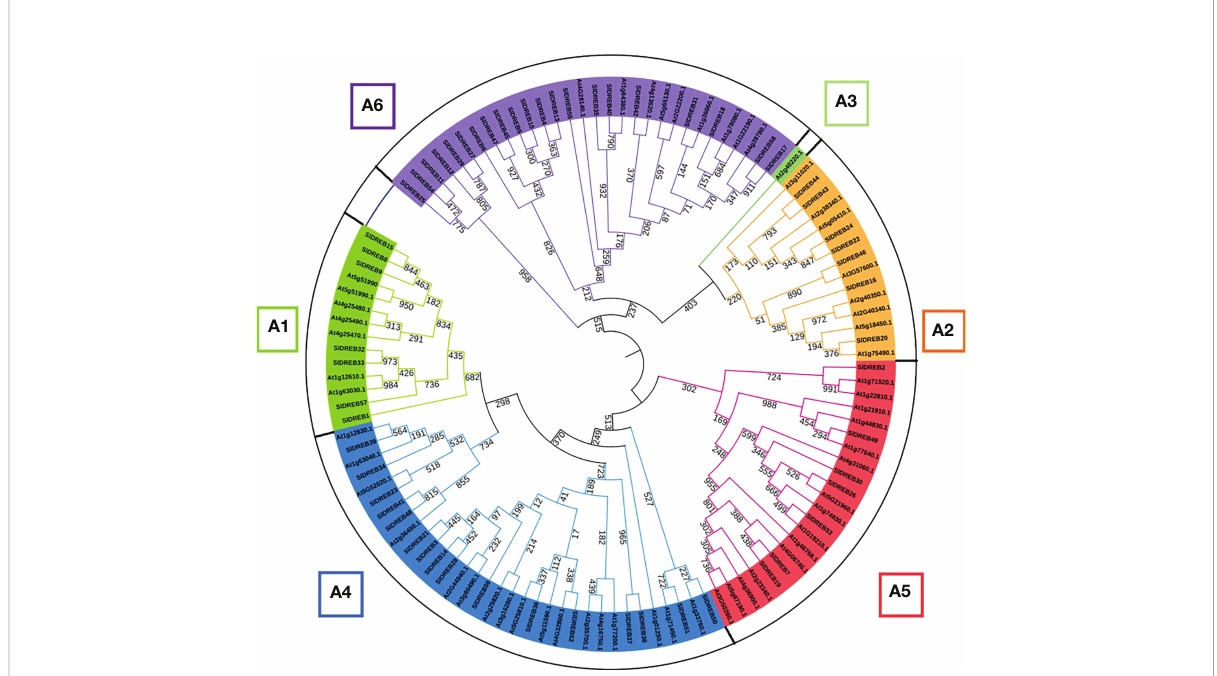
FIGURE 2 Phylogenetic tree of dehydration-responsive element-binding proteins of S. lycopersicum and A. thaliana . MEGA 11 software was utilized with 1,000 bootstrap and maximum likelihood method. Each color represents a speci fi c